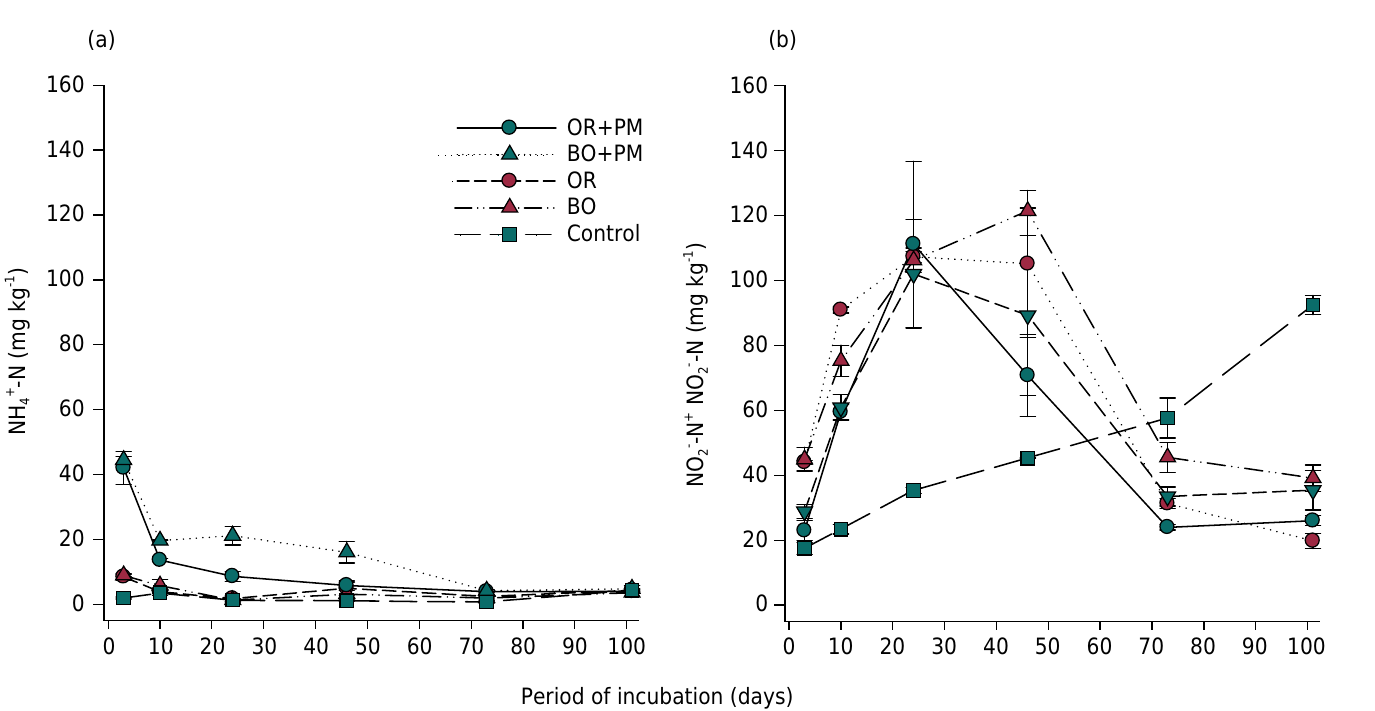
Figure 3. Temporal variations in NH 4+ -N (a) and NO 3- -N+NO 2- -N (b) contents in soil incubated with residues of oilseed radishes + poultry manure (OR + PM), black oats + poultry manure (BO + PM), oilseed radishes (OR), black oats (BO), and control (C). Vertical bars indicate the standard error of the mean (n = 3).